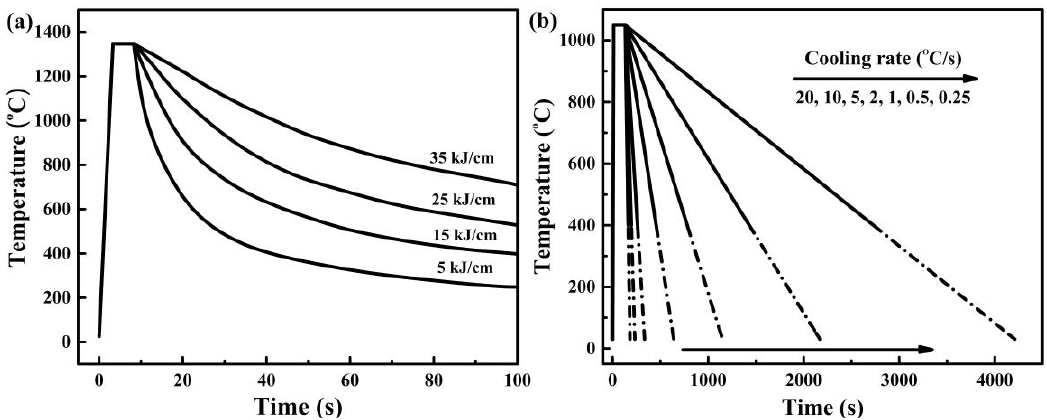
Figure 1. The simulated welding thermal cycles with different ( a ) heat inputs, and ( b ) cooling rates .